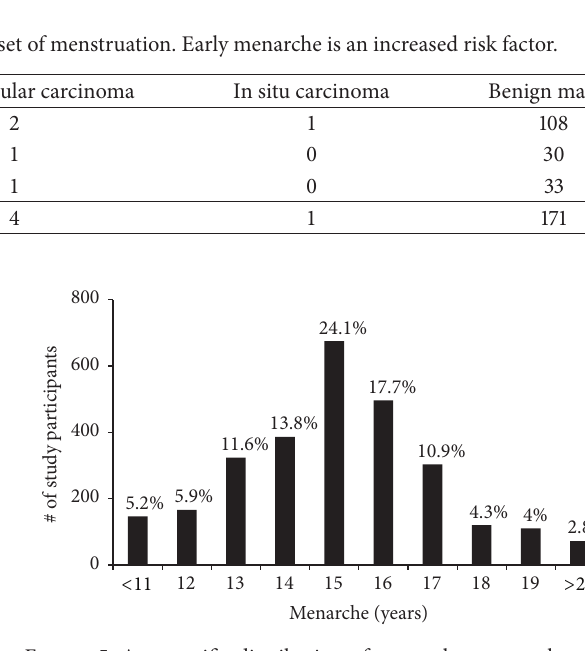
Figure 5: Age specific distribution of menarche among the study participants. The average female in Ghana experiences menarche at 15years.Participantsbelow15yearswereclassifiedasearlymenarche and above 15 years were classified as late menarche.